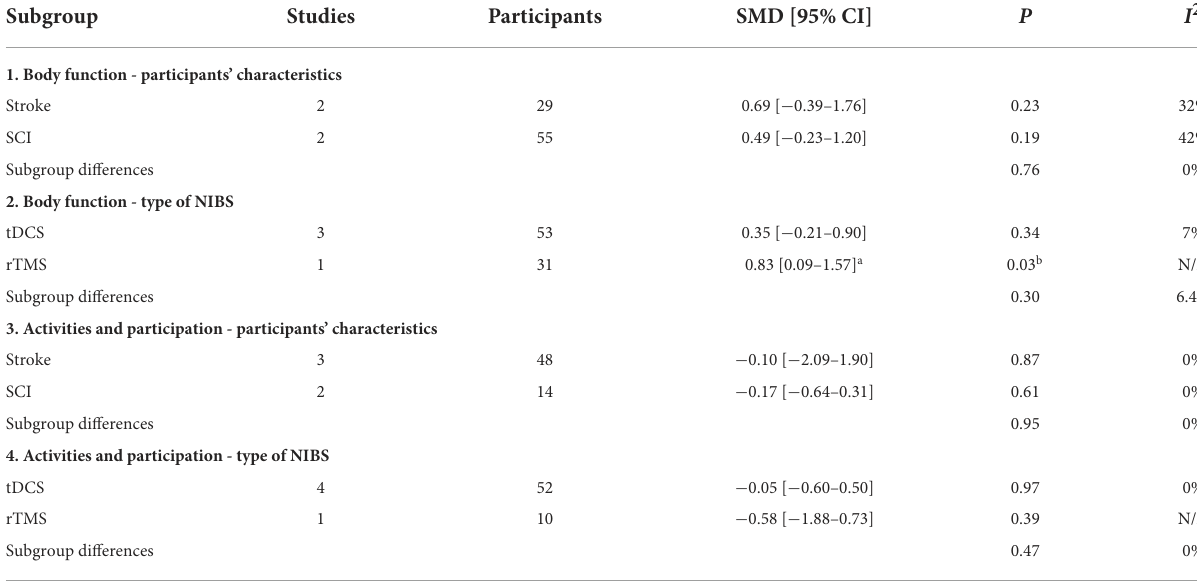
TABLE 2 Subgroup analysis of participants’ characteristics (stroke or SCI) and type of NIBS (tDCS or rTMS).